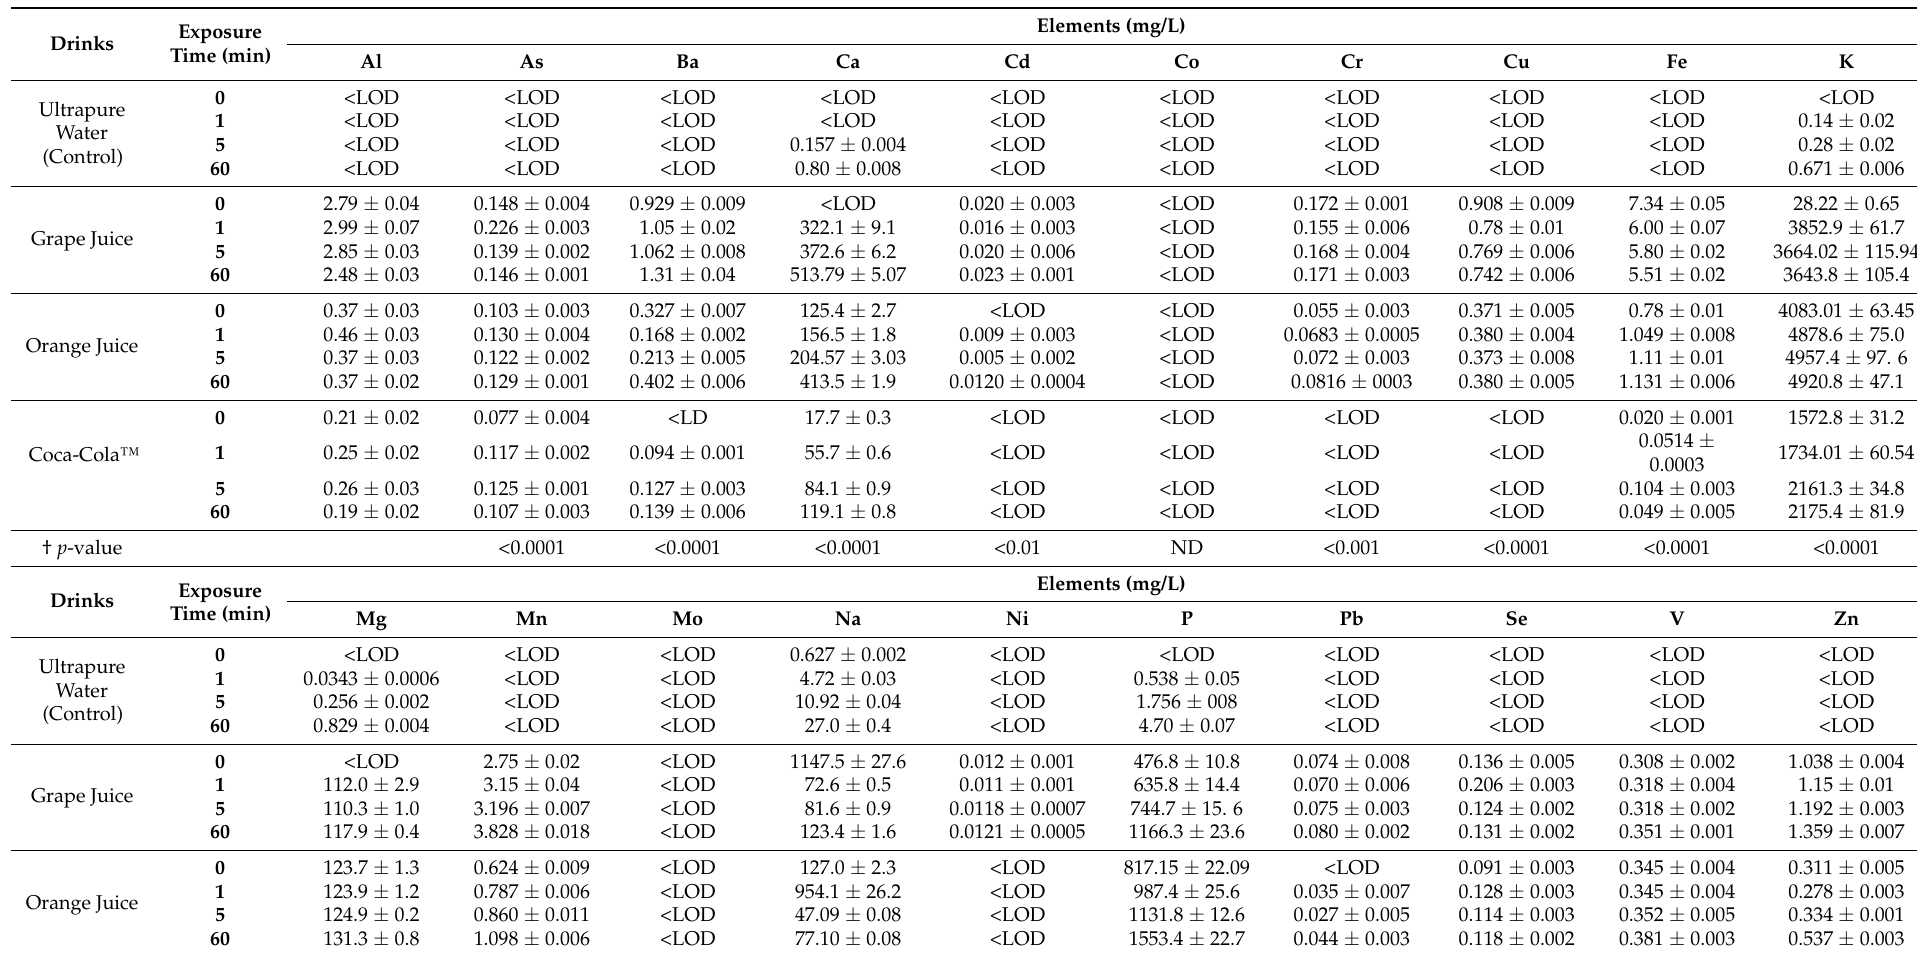
Table 3. Concentration of minerals detected before (t = 0) and after the erosive challenge in vitro (t = 1, 5, and 60 min). Values are expressed as mean ± SD. Statistical results: p -values.